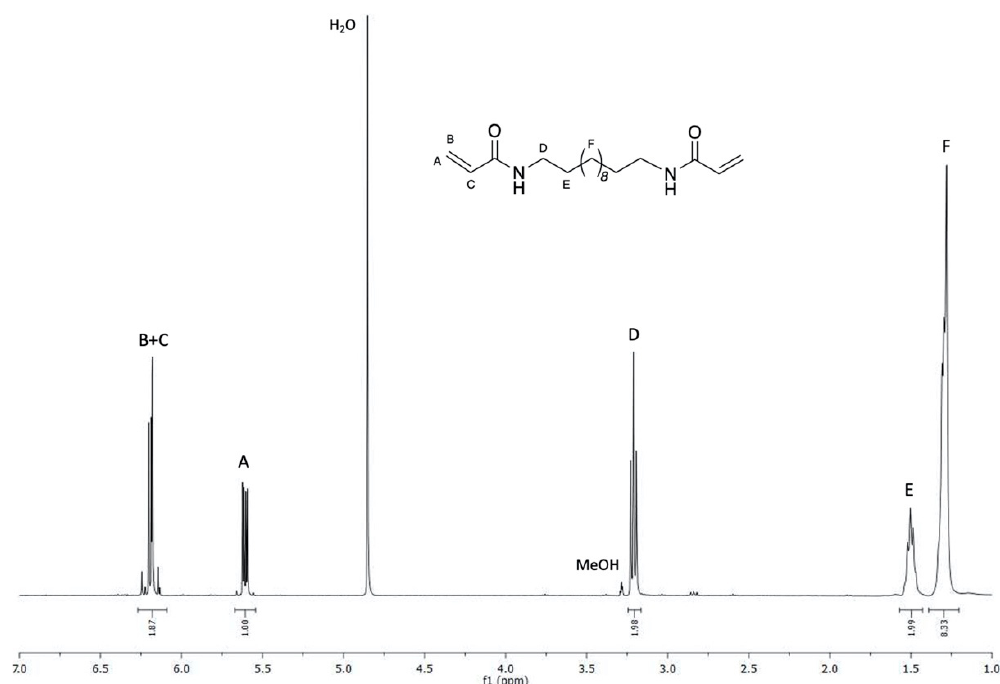
Figure 1. 1 H-NMR spectrum of bis-acrylamide B12 obtained in CD 3 OD using a 400 MHz Avance Brüker spectrometer. Water assignment was in agreement with the literature [33,34].